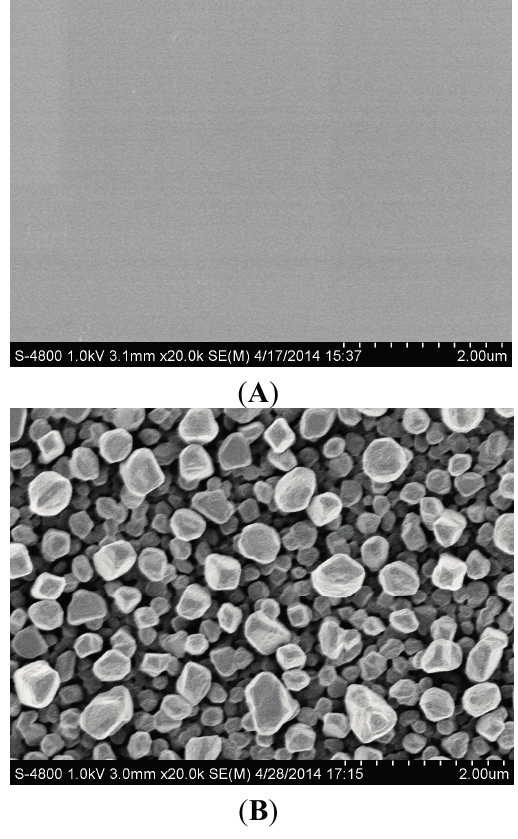
Figure 4. Cyclic voltammetric response in 0.01 M sulfuric acid. a : AuNPs-modified microelectrode; b : unmodified